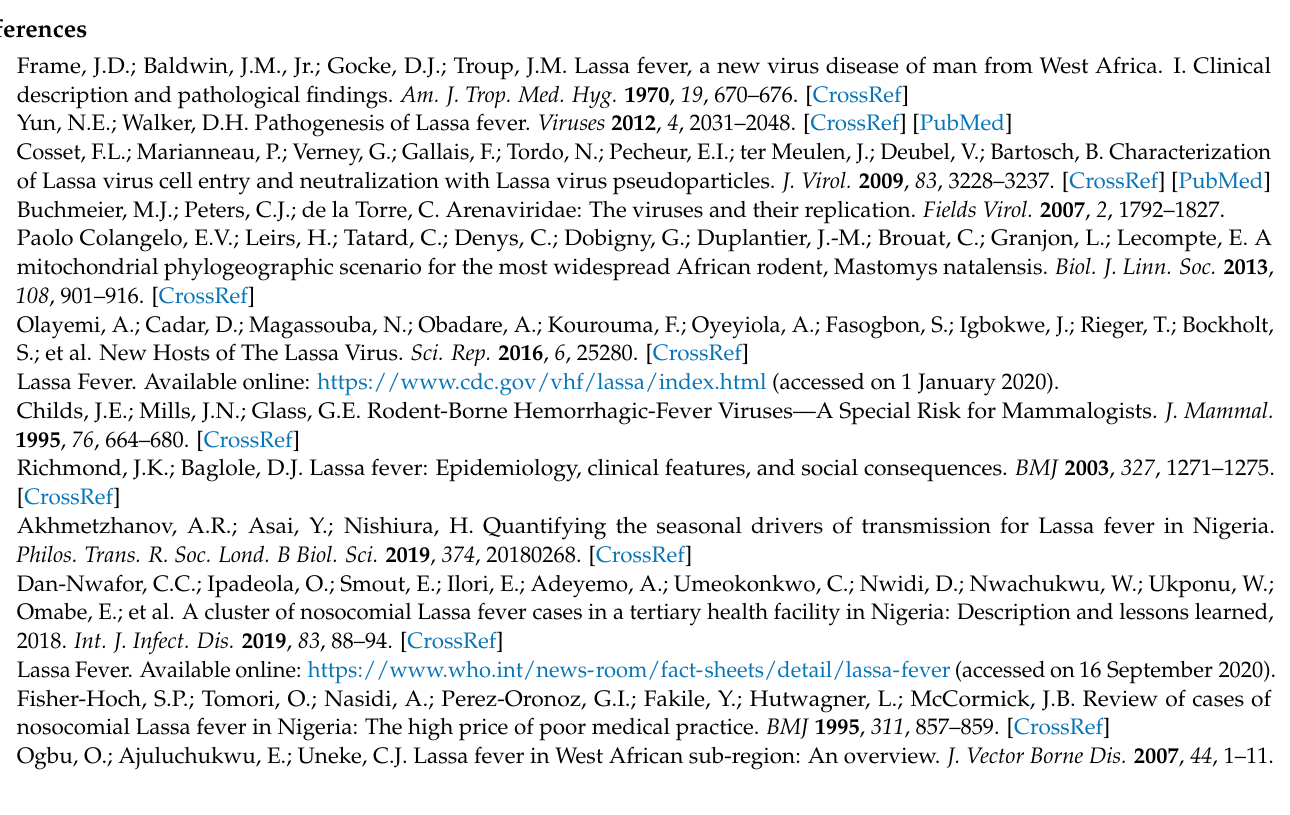
Table S3: Therapeutics for LASV in rodent animal models, Table S4: Antibody based therapeutics for LASV in rodent animal